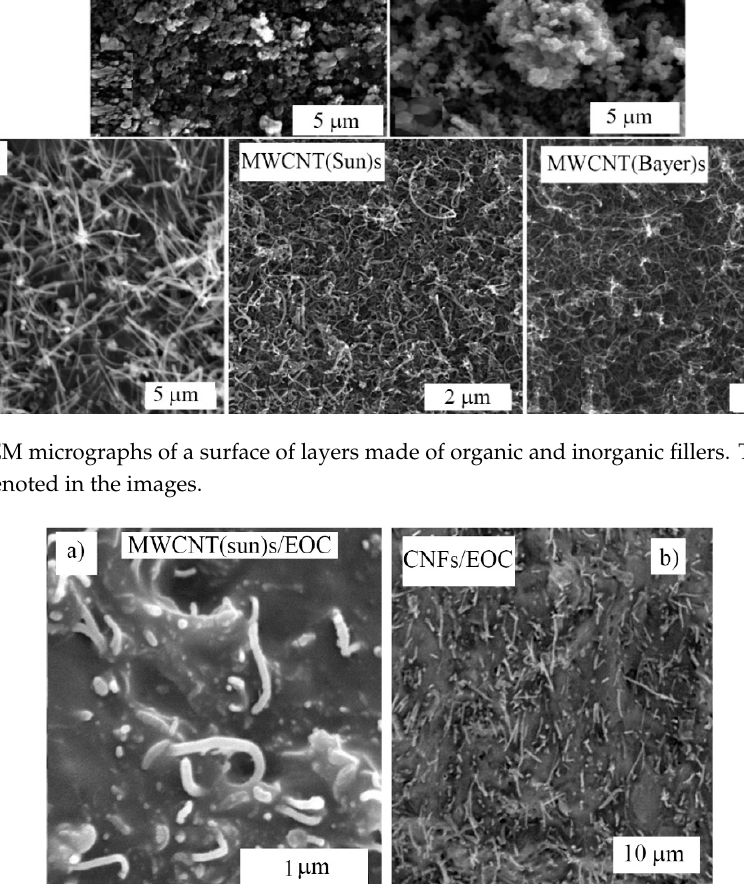
Figure 4. SEM images of cross-sections of carbon allotrope/ethylene-octene-copolymer matrices (EOC) composites. The respective composites are denoted in the images.